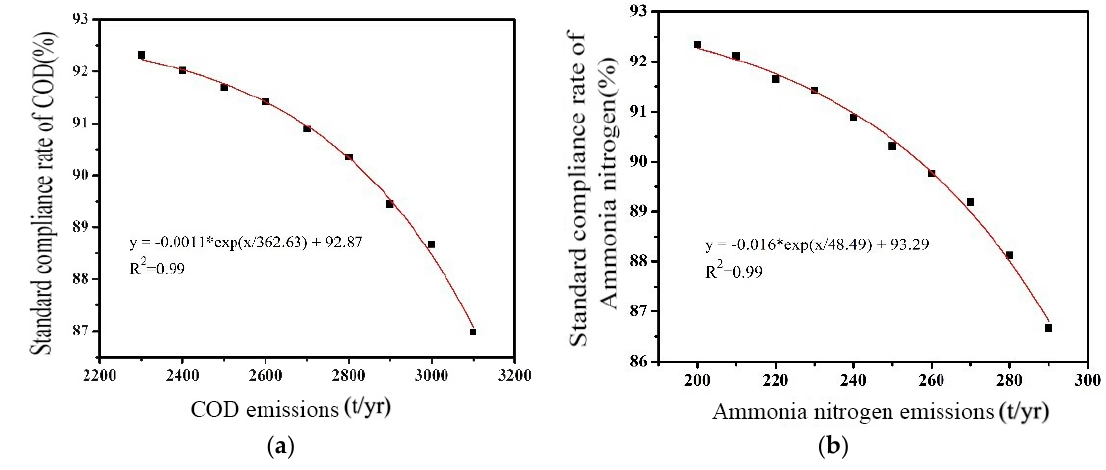
Figure 4. Relationship between the pollutant discharge and guaranteed rate of water quality standard compliance of the control section. ( a ) COD; ( b ) ammonia nitrogen.